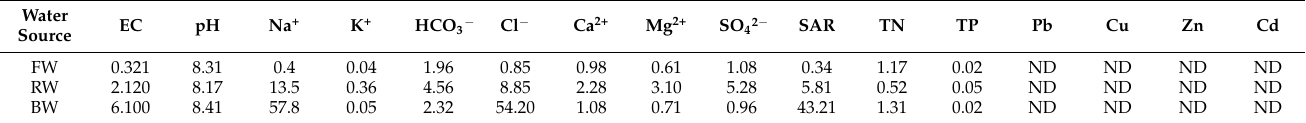
Table 3. Quality of different water sources for the